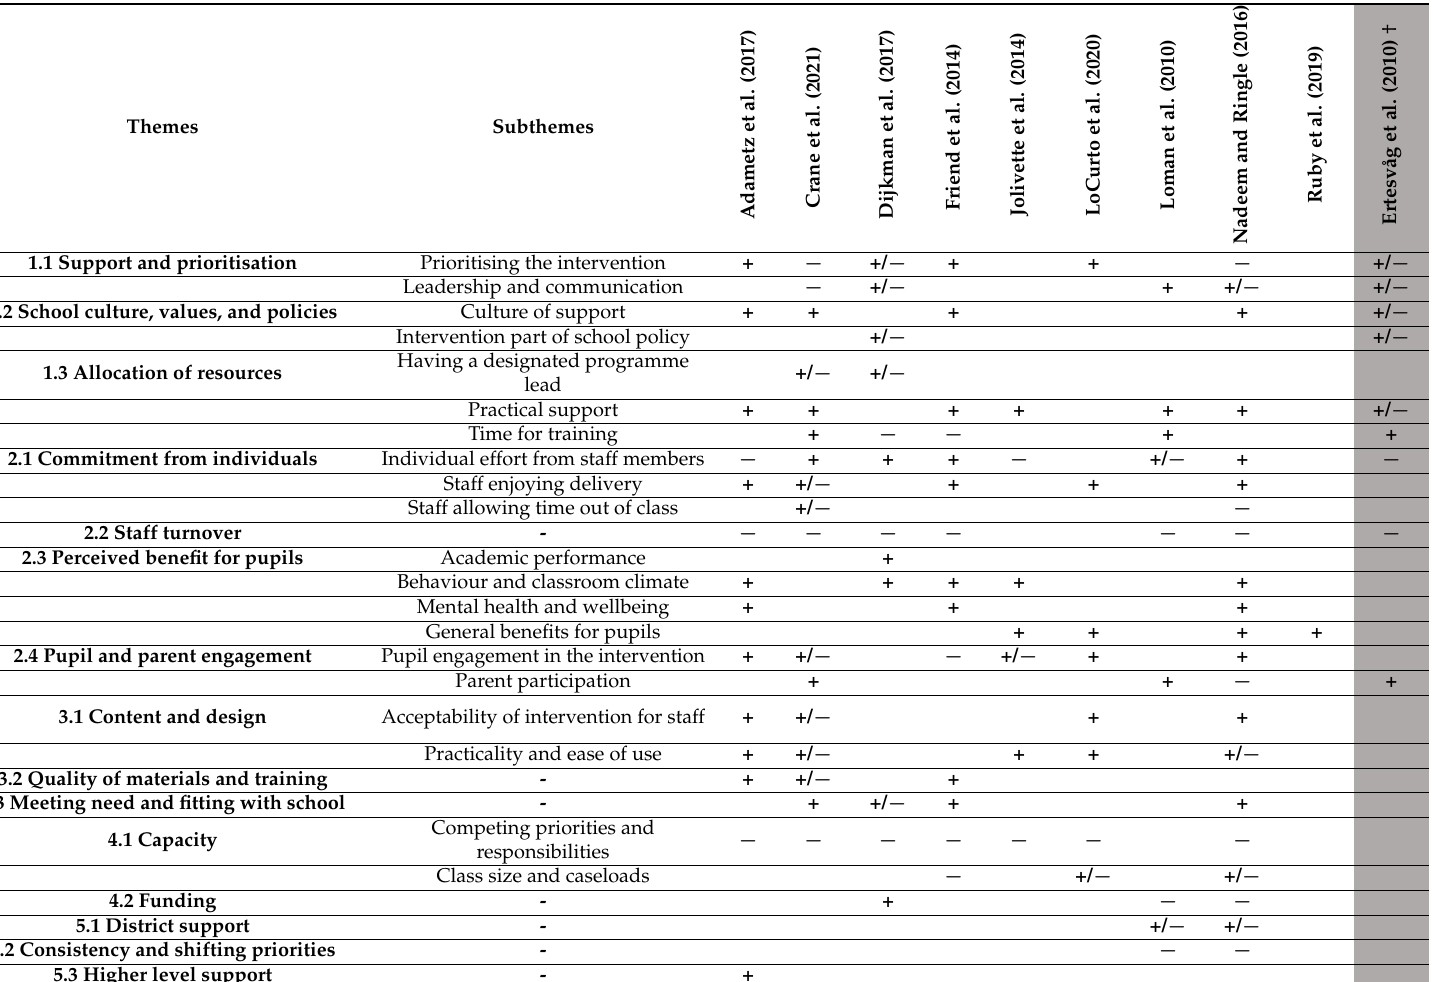
Table 4. Barriers and facilitators to sustaining mental health programmes in